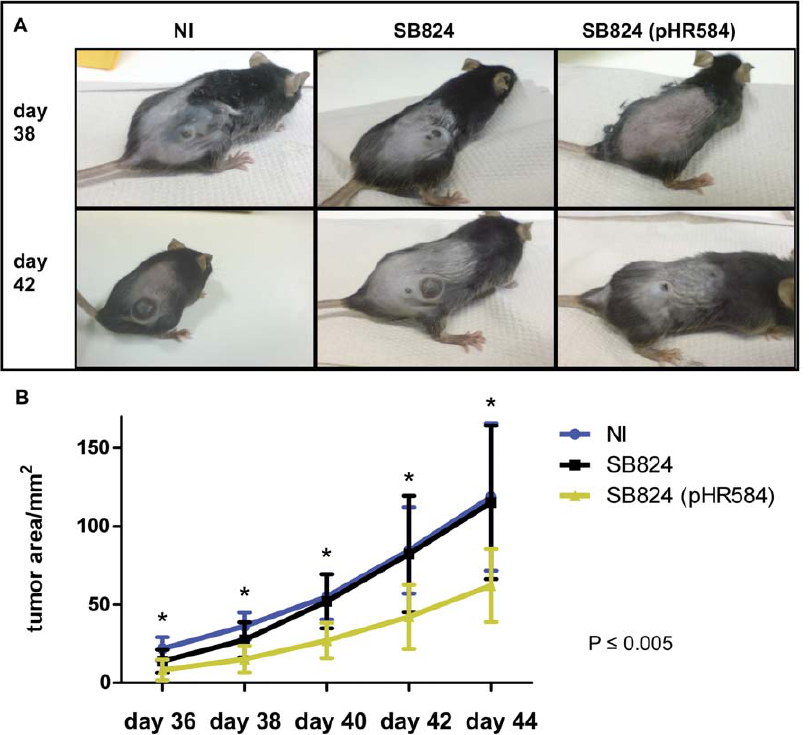
Figure 5. Significant reduction of melanoma tumor growth by Salmonella -mediated vaccination against VEGFR2. A Photographs of the clinical outcome of C57Bl/6 mice with subcutaneous B16 melanoma tumors. From left to right representative mice from experimental groups NI, SB824 and SB824 (pHR584) on day 38 and day 42 are shown. B Tumor growth was monitored over time and the mean tumor area was calculated. Asterisks indicate values that differ significantly from the corresponding values obtained from mice of both control group (*, p # 0.005).